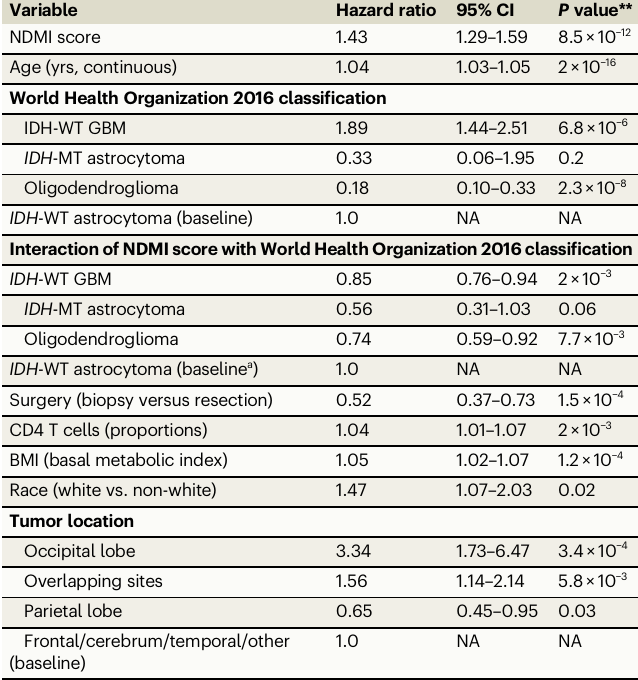
Table 3 | Neutrophil dexamethasone methylation index (NDMI) is a prognostic factor in glioma survival: Cox multi- variate model of NDMI and glioma survival in 429 UCSF Adult Glioma Study patients